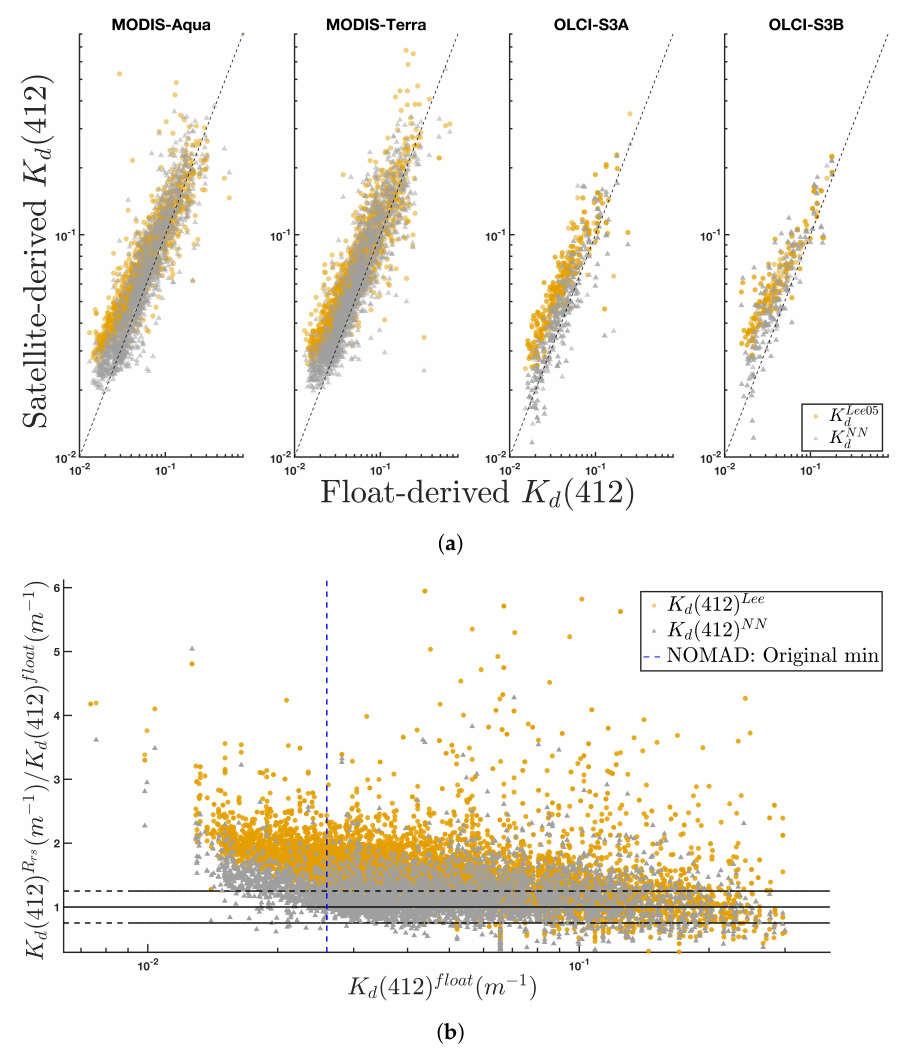
Figure 4. Comparison of satellite-derived and float-derived K d ( 412 ) for the two MODIS and the two ( 412 ) computed using the 2 different algorithms compared to K float OLCI sensors: ( a ) K R rs d black dashed line is the 1:1 line. ( b ) K R rs / K float for the matchups; the solid black line is a ratio of 1, d d and the dashed black lines denote ratios of 0.75 (Bottom) and 1.25 (Top) ratio; the dashed blue line indicates the minimum value of K d ( 411 ) present in the NOMAD dataset